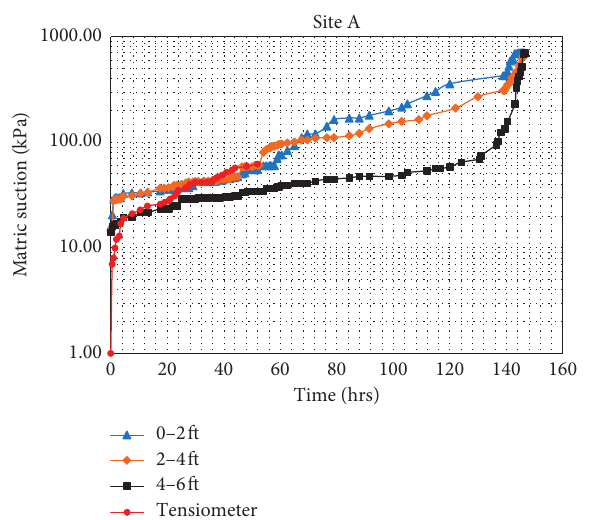
Figure 12: Matric suction relation concerning time for site